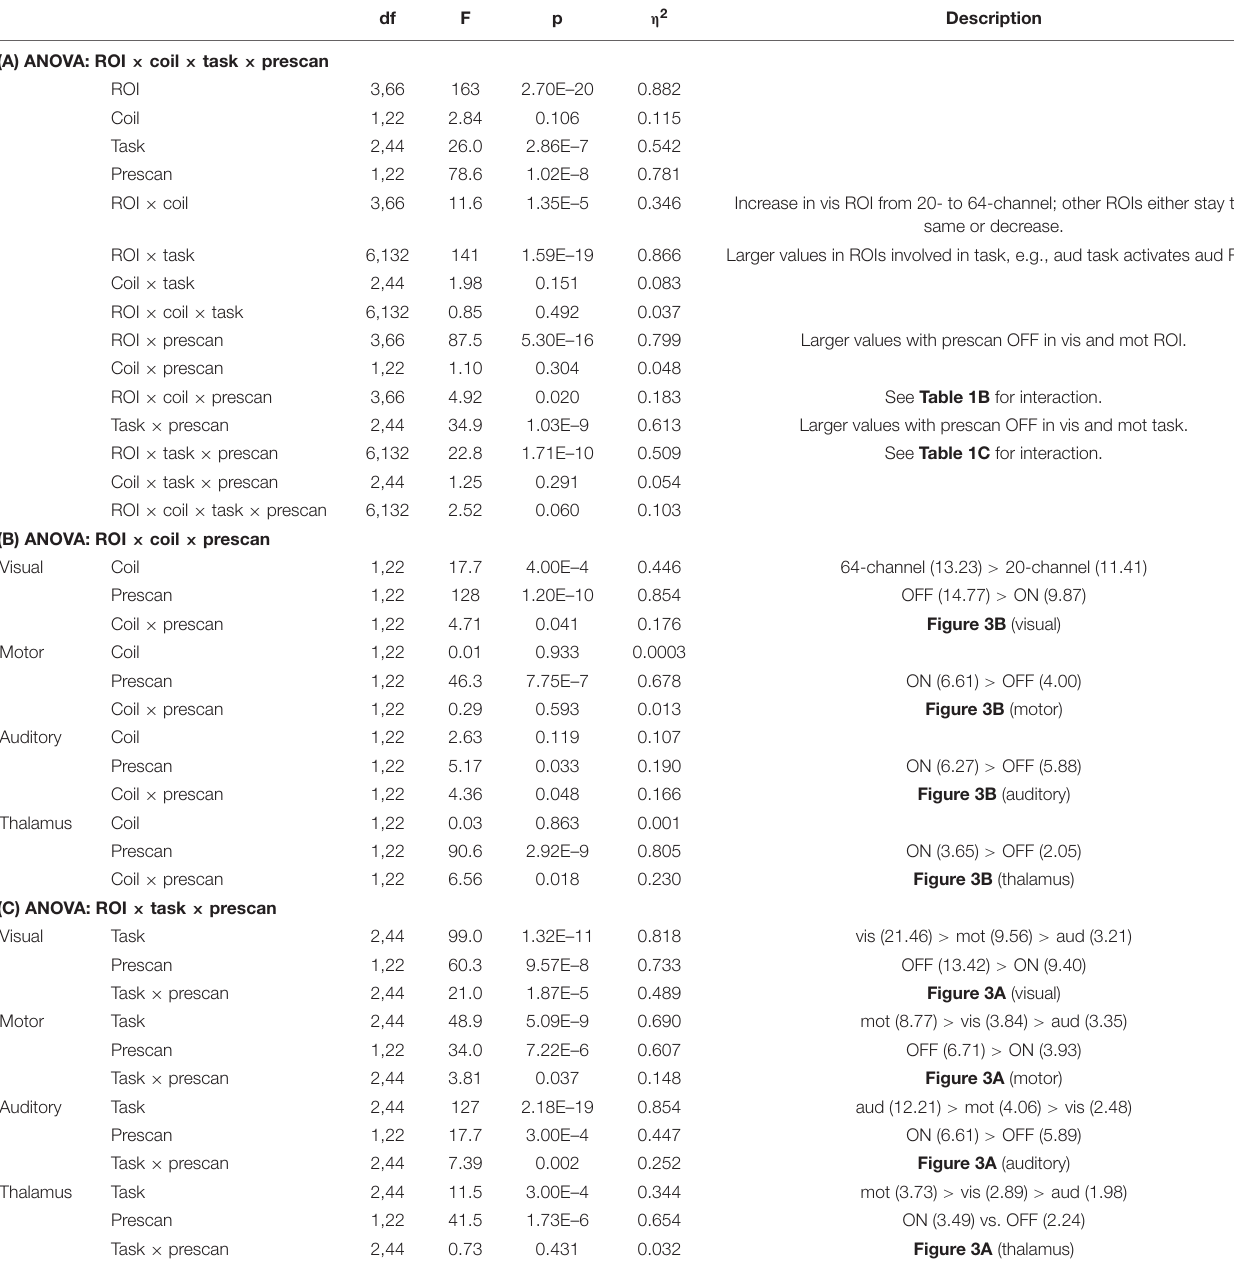
TABLE 1 | Results for extracting β estimates in highest activated